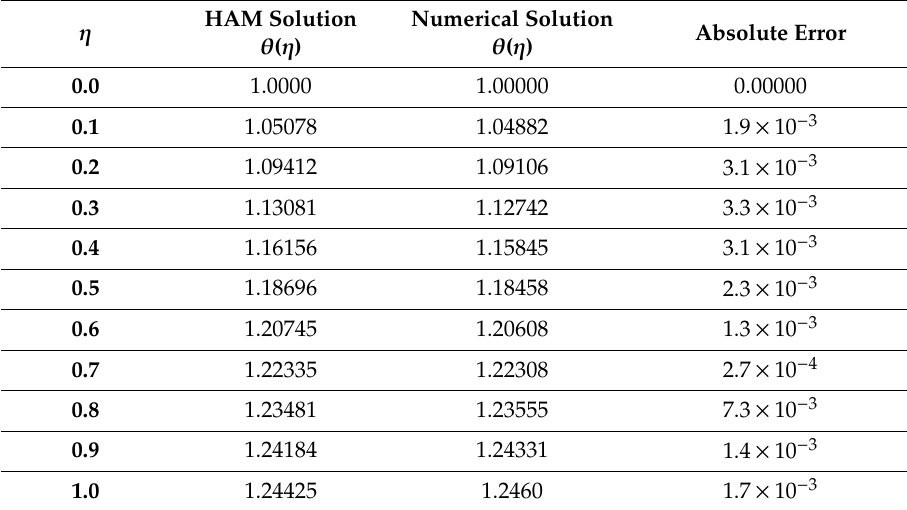
Table 3. Comparison of HAM and numerical solution for θ ( η ) .